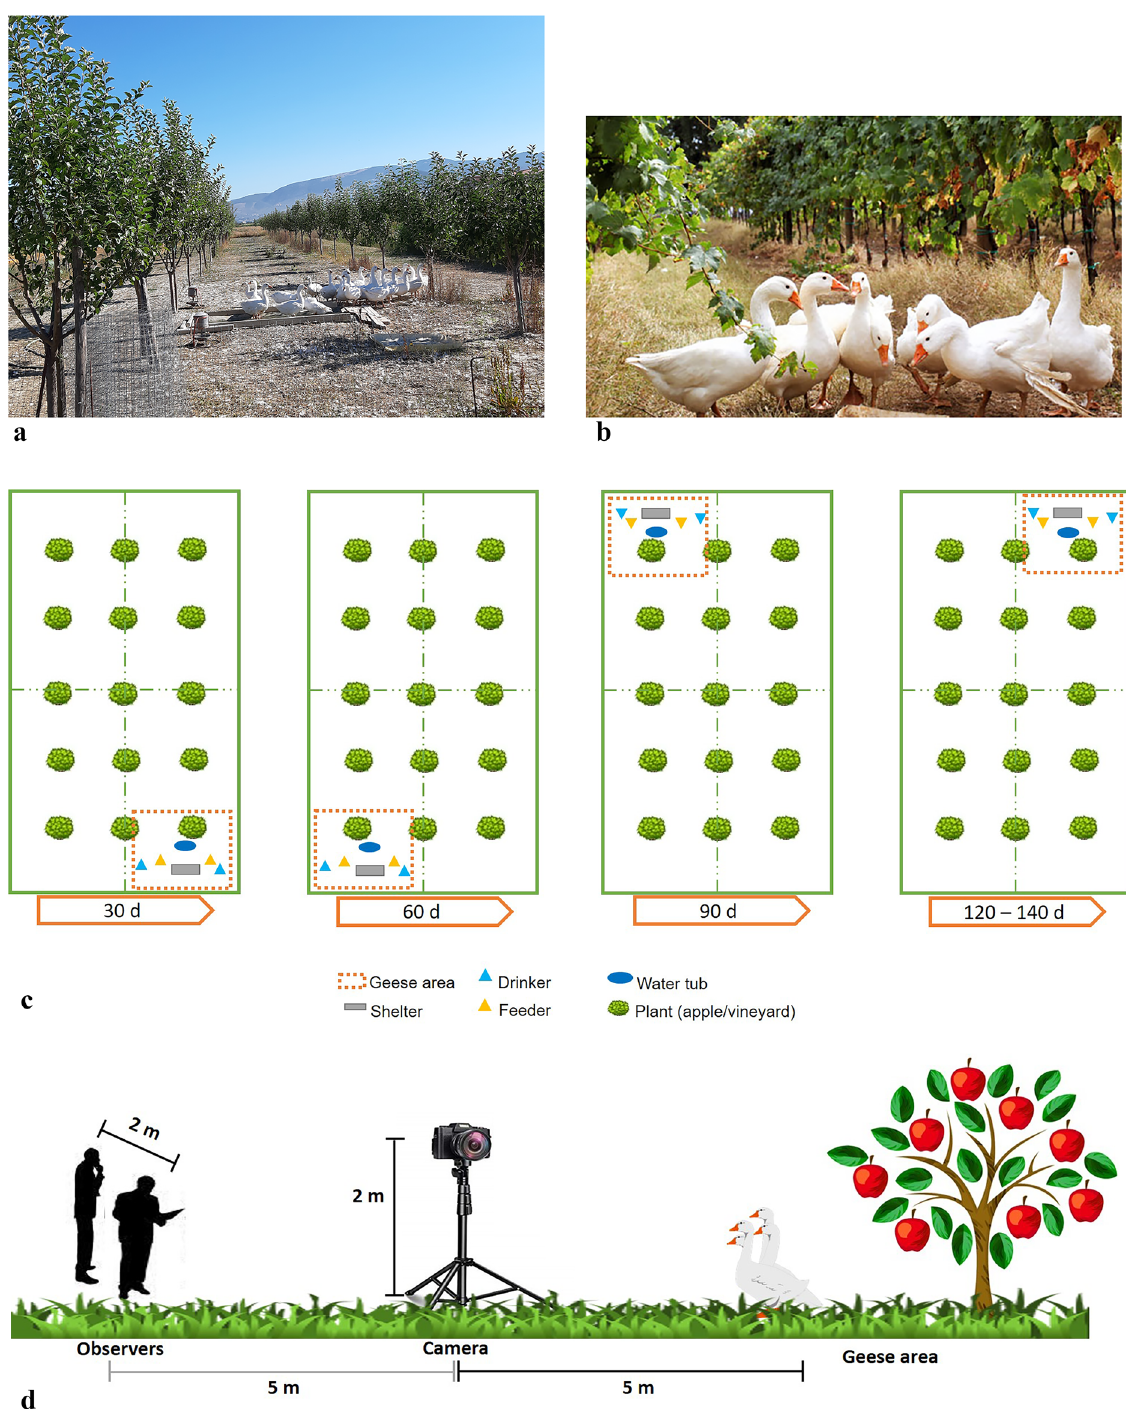
Figure 3. Housing, animals, and management. Geese in the ( a ) apple orchard and ( b ) vineyard. ( c ) Graphical representation of the “geese area” displacement. The mobile shelter with the other facilities was moved within the pen every 30 days. ( d ) Graphical representation of the study site indicating the position of the camera and observers in relation to the geese